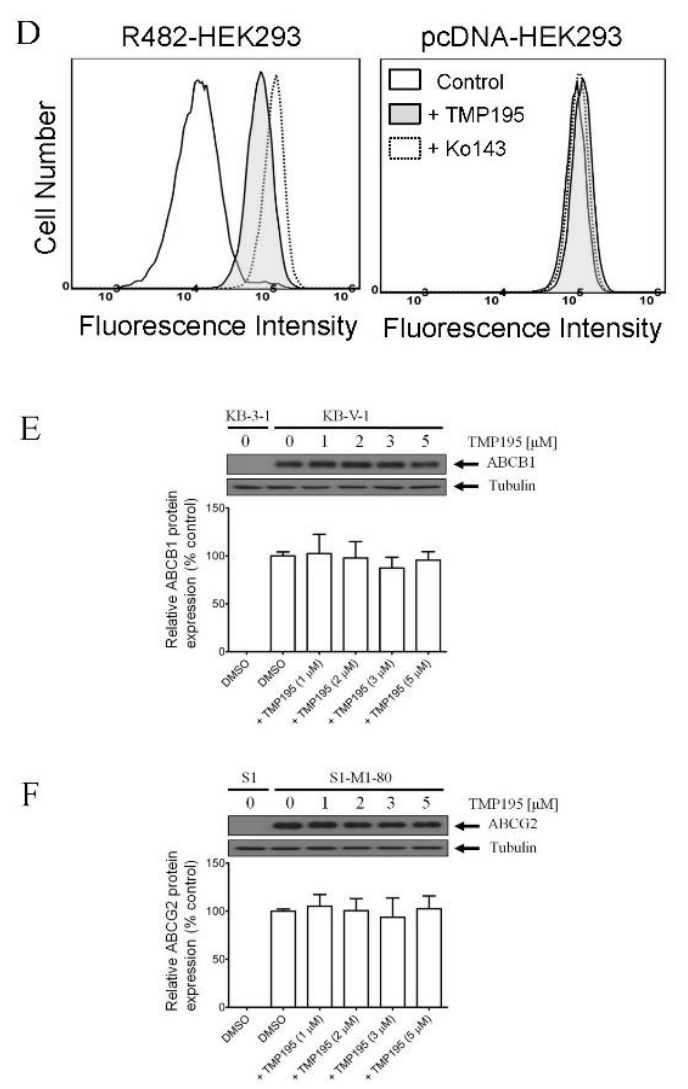
Figure 3. TMP195 modulates the drug efflux function, but not the protein expression, of ABCB1 and ABCG2 in human multidrug-resistant cancer cells. The effect of TMP195 on ABCB1-mediated transport of calcein-AM, a known substrate of ABCB1, was determined in ( A ) ABCB1-overexpressing KB-V-1 human epidermal cancer cells and ( B ) human HEK293 cells transfected with human ABCB1 (MDR19-HEK293), whereas the effect of TMP195 on ABCG2-mediated transport of pheophorbide A (PhA), a known substrate of ABCG2, was determined in ( C ) ABCG2-overexpressing S1-M1-80 human colon cancer cells and ( D ) HEK293 cells transfected with human ABCG2 (R482-HEK293). Respective drug-sensitive parental cell lines were used as controls (A–D, right panels). Intracellular fluorescence of calcein (A and B) or PhA (C and D) was measured in cells treated with DMSO (A–D, solid lines), 20 μM of TMP195 (A–D, filled solid lines), 20 μM of verapamil as a positive control for ABCB1 inhibition (A and B, dotted lines), or 1 μM of Ko143 as a positive control for ABCG2 inhibition (C and D, dotted lines) as indicated and analyzed by flow cytometry. Representative histograms of at least three independent experiments are shown. The effect of TMP195 on the protein expression of ABCB1 or ABCG2 was determined by treating ( E ) KB-V-1 cancer cells or ( F ) S1-M1-80 cancer cells with increasing concentrations of TMP195 (0–5 μM) as indicated for 72 h before processing for immunoblotting. α-Tubulin was used as an internal loading control. Immunoblot detection (upper panels) and quantification values (lower panels) are presented as mean ± SD calculated from at least three independent experiments.